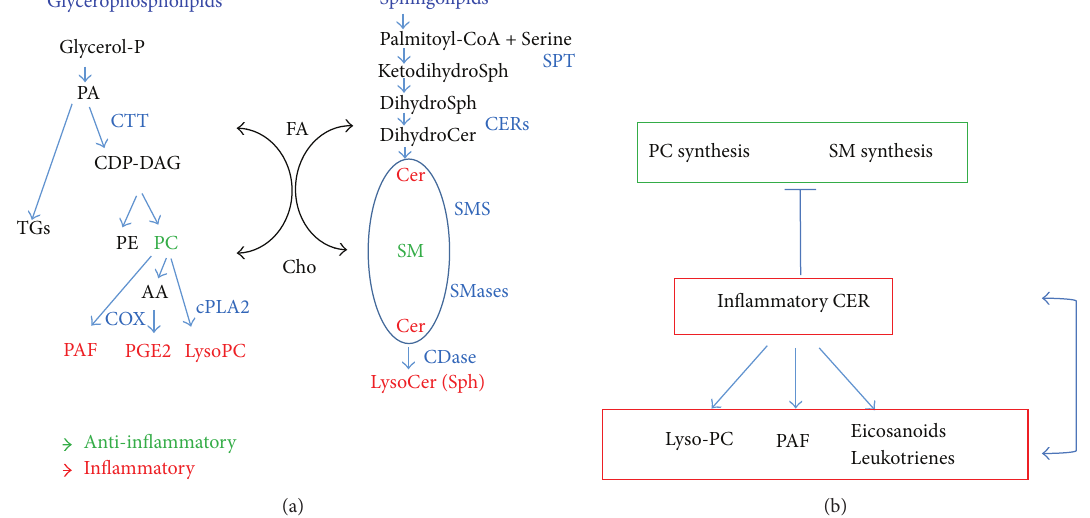
Figure1:Sphingolipidsmetabolitesformanetworkwithotherinflammatorylipidsinthelung.(a)Intracellularandsecretorylipidsregulating inflammation in mucus and mucosa. Red: inflammatory lipids and major controlled enzymatic activities. Green: anti-inflammatory lipids and major controlled enzymatic activities. P, phosphate; FA, fatty acids, Cho, choline; CDP, citidyl diphosphosphate; DAG, diacylglycerol; TGs, triglycerides; PE, phosphatidyl ethanol ammine; PC, phosphatidyl choline; PAF, platelet activating factor; AA, arachidonic acid; PGE2, prostaglandins E2; Sph, sphingosine; Cer, ceramide, SM, sphingomyelin; CTT, CTP: Phosphocholine Cytidyl-Transferase; SMase, Sphingomyelinase, SMS, Sphingomyelin Synthase, and CERS, Ceramide Synthases; SPT, Serine Palmitoyl Transferase; cPLA2, Cytosolic Phospholipase 2. (b) Ceramide accumulation controls other inflammatory and anti-inflammatory lipids. Red: inflammatory lipids and major controlled enzymatic activities. Green: anti-inflammatory lipids and major controlled enzymatic